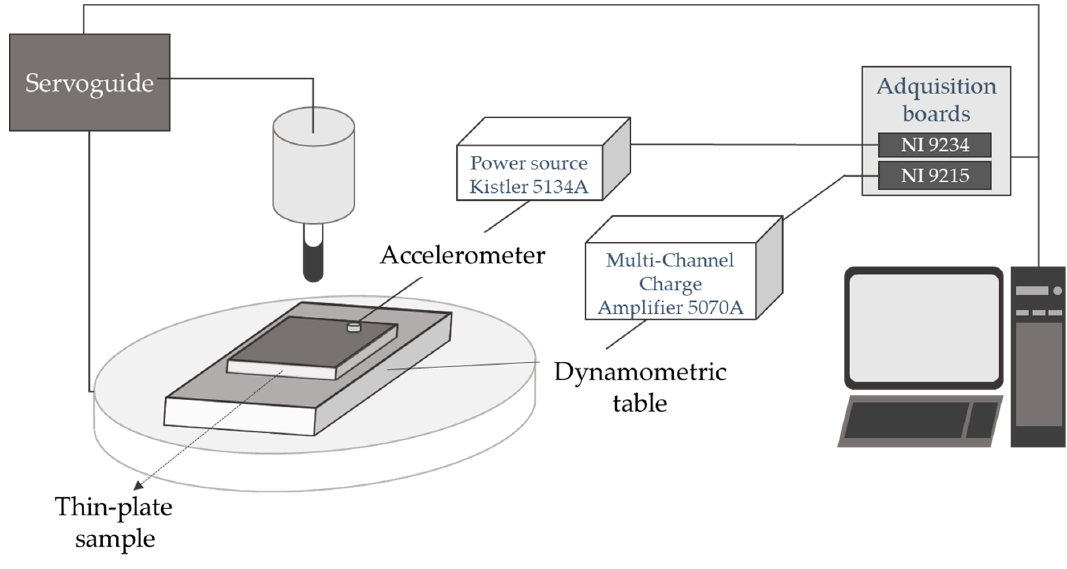
Figure 1. Scheme of the monitoring system.